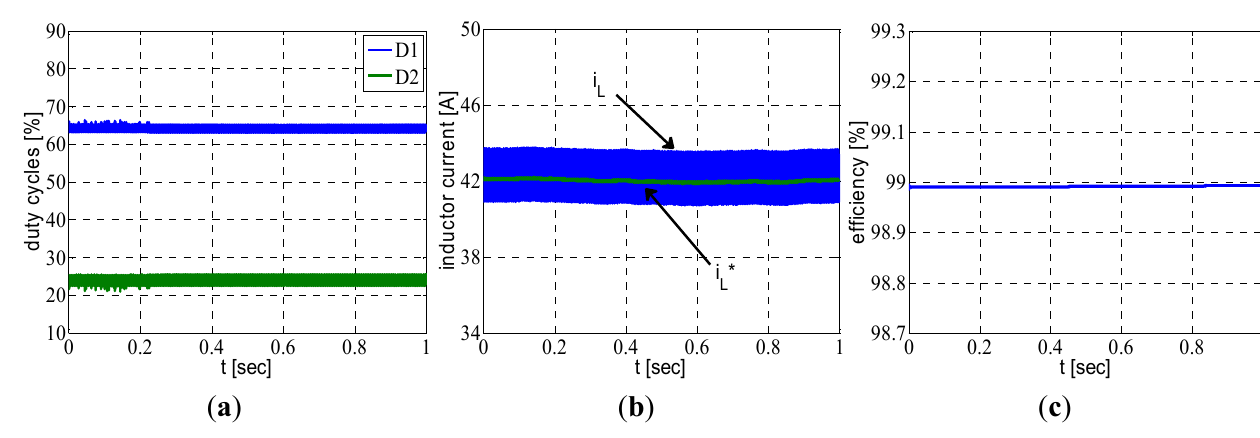
Figure 11. Fixed voltage and load results: ( a ) duty cycles; ( b ) inductor current; ( c ) converter